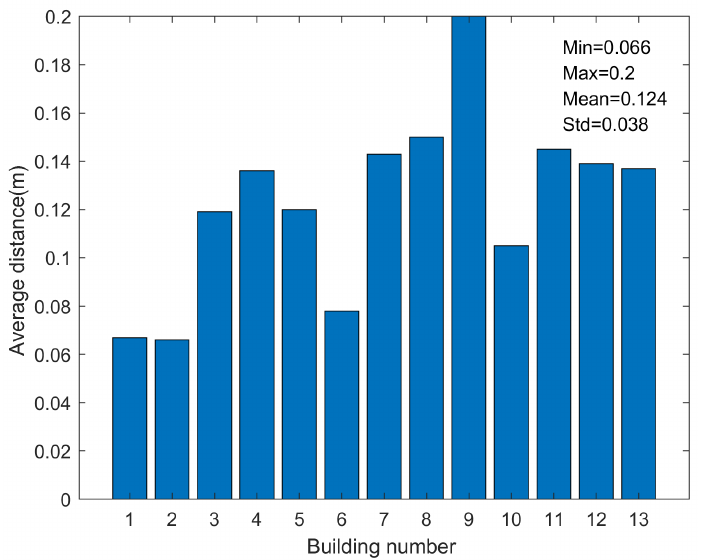
Figure 12. The façade reconstruction result.